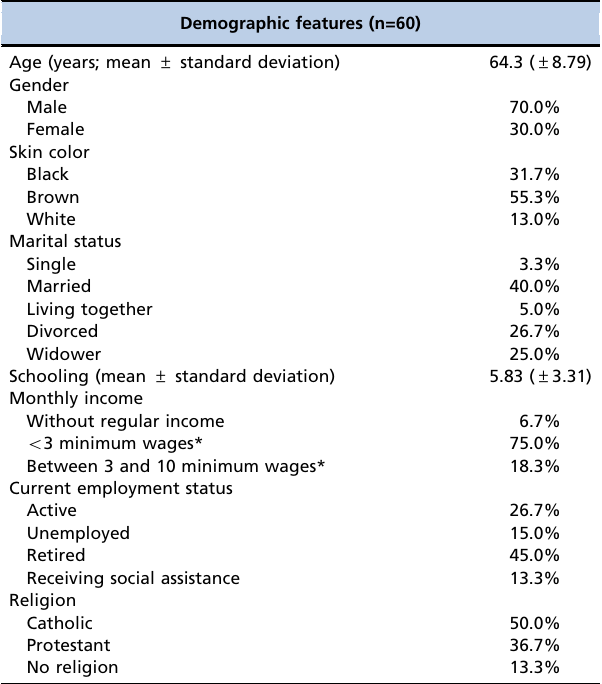
Table 1 - Demographic features of a sample of 60 in-hospital patients after ischemic acute stroke.